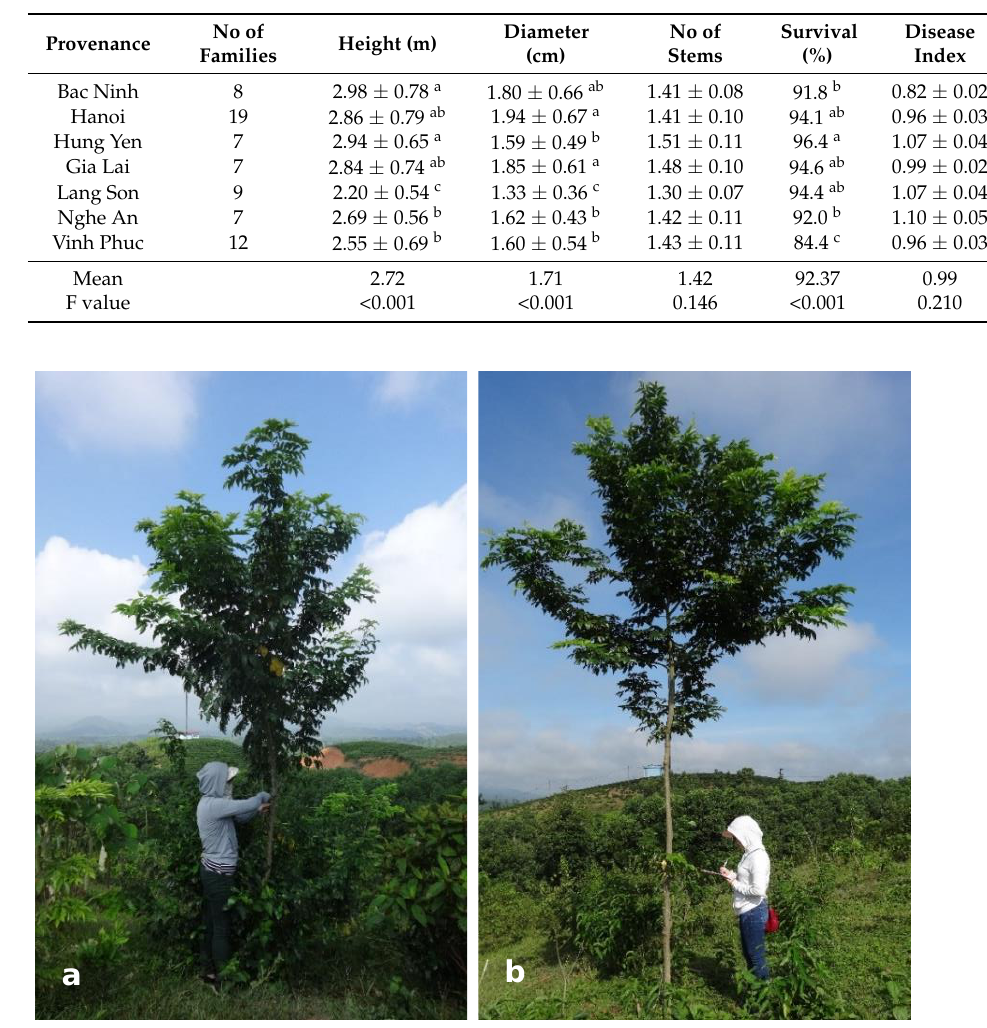
Figure 3. Three-year-old D. tonkinensis planted in Tan Son: ( a ) superior family from Hung Yen; ( b ) superior family from Bac Ninh. Note the smaller trial trees surrounding the emergent trees. The correlation matrix for the characteristics of mother trees (Ht, Dbh, leaves, 1000 seed- weight) and the average of their progenies in the field trial (Height, Dbh, disease